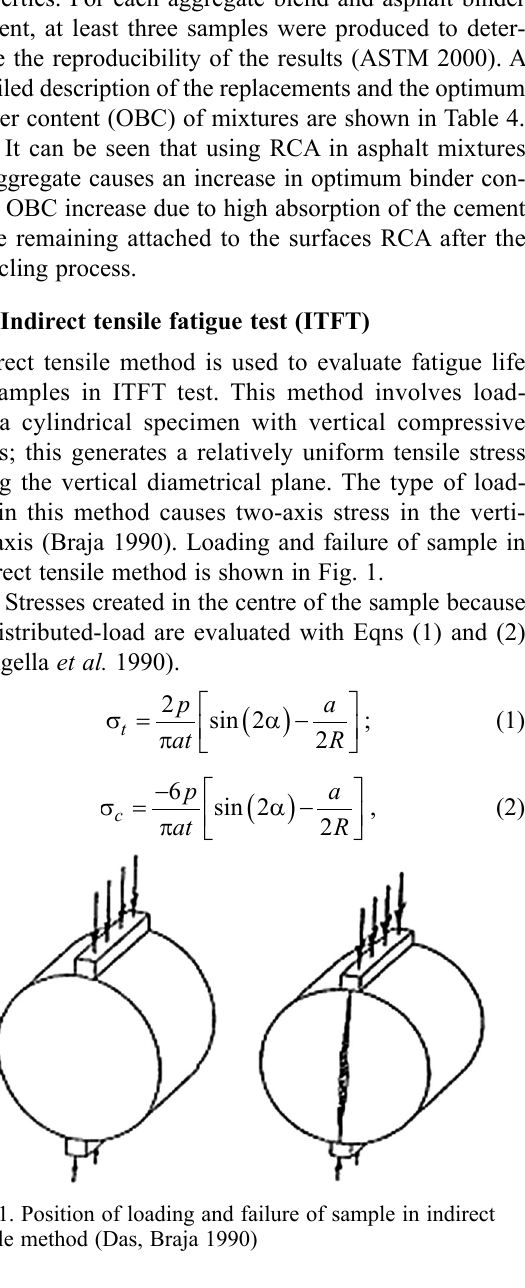
Table 4. RCA replacement values and optimum asphalt content of tested mixes Mixture Coarse